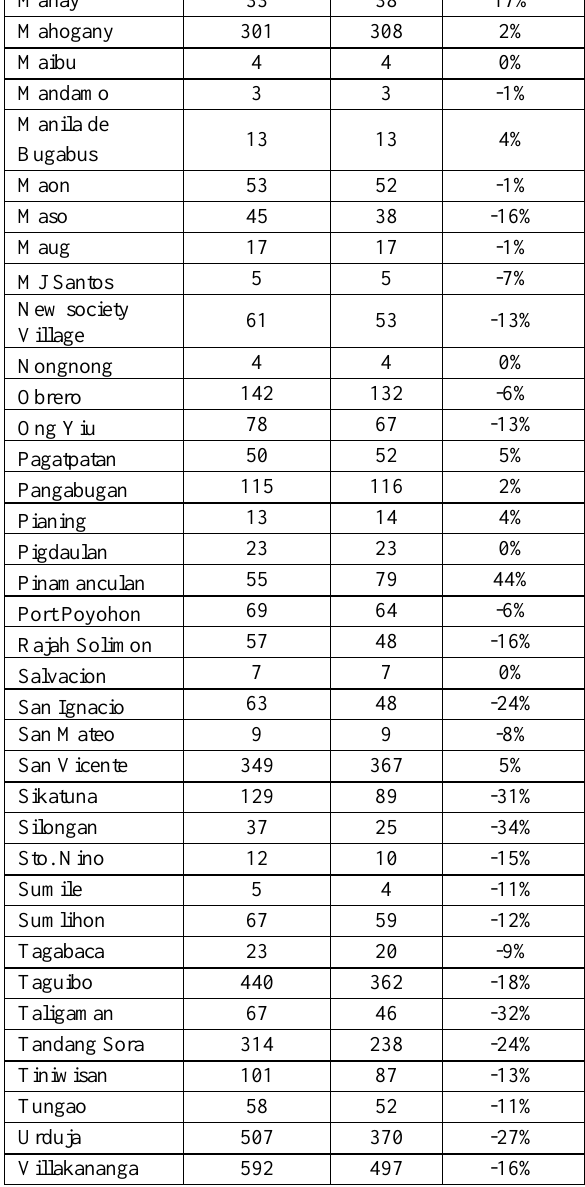
Table 1. Summary of carbon footprint increase or decrease during pre-lockdown and lockdown